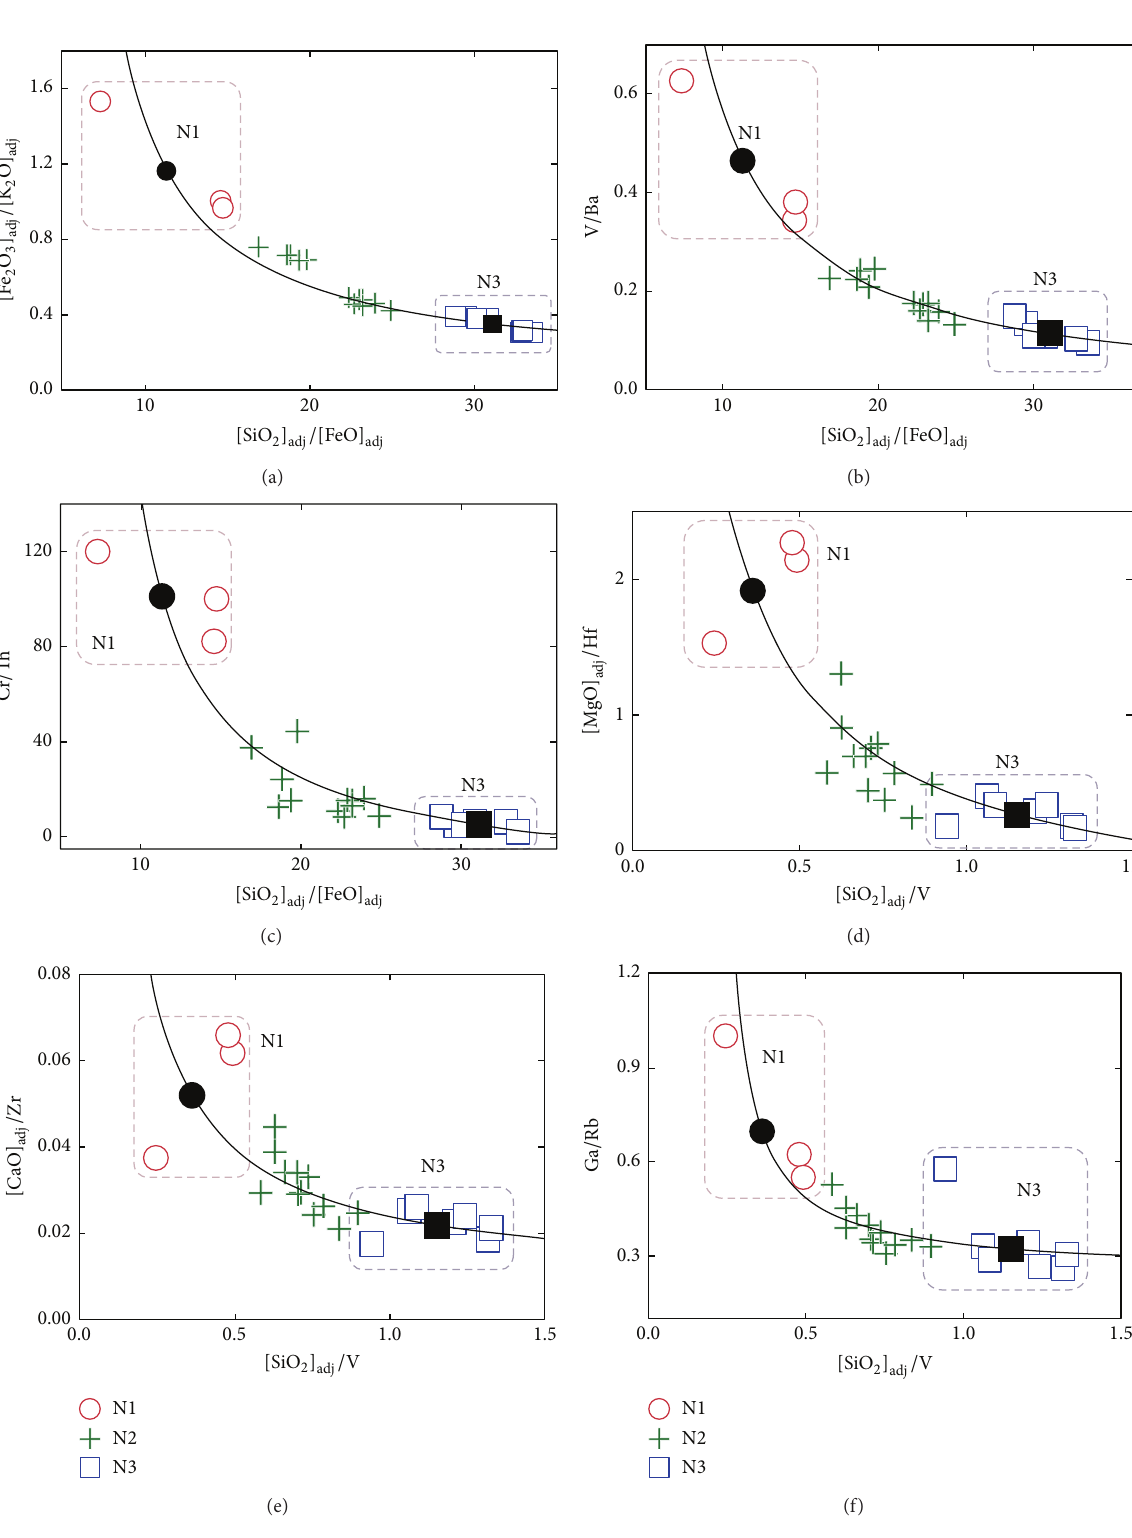
) and average felsic N3 lavas (black filled square, 𝐹 SC /[ FeO ] ; (c) Cr/Th −[ SiO 2 ] adj adj